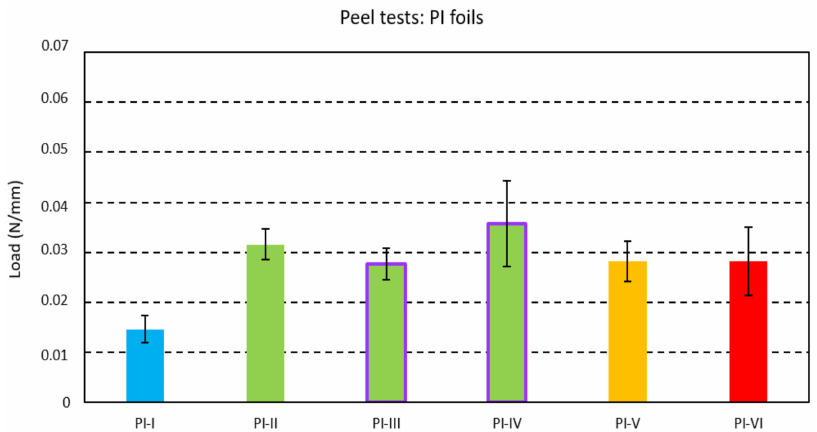
Figure 5. Peel strength for the PI foils with an acrylic-based adhesive layer.